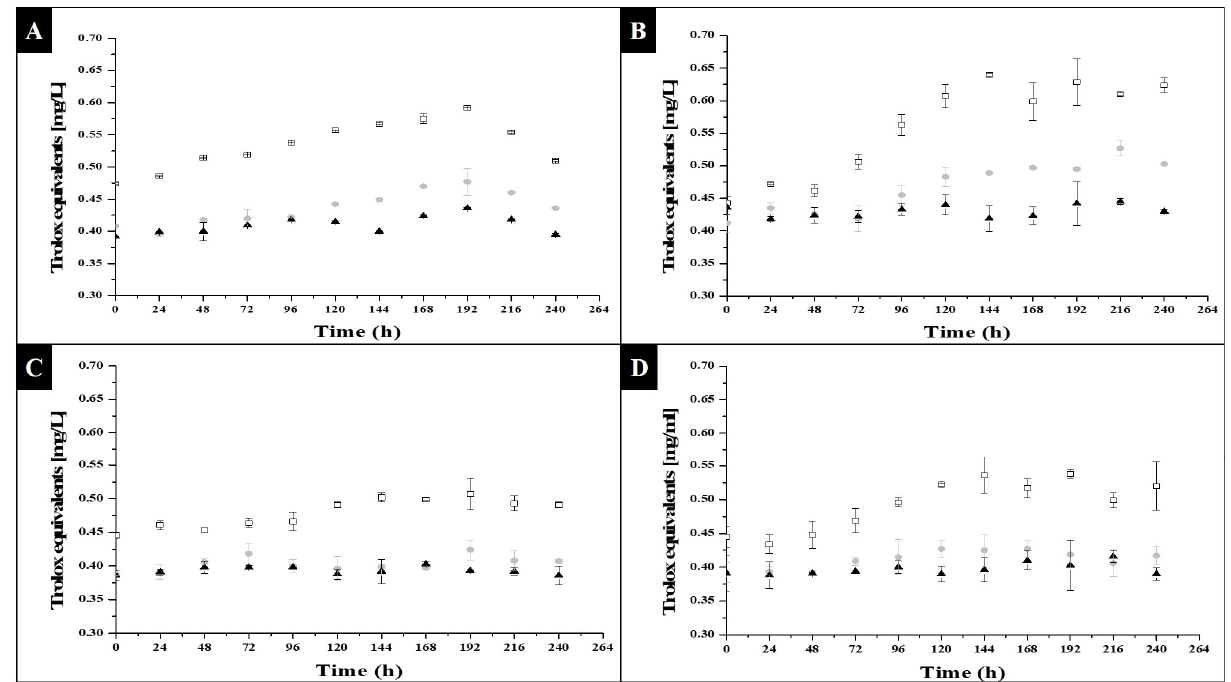
Figure 4. Antioxidant activity of C. vulgaris under photoheterotrophic growth with ABTS • + method: ( A ) sodium acetate in 8 light hours and 16 darkness photoperiods; ( B ) sodium acetate in 16 light hours and 8 darkness photoperiods. (cid:3) 0.0005 g/L, • 0.001 g/L and (cid:78) 0.0015 g/L sodium acetate concentration; ( C ) glycerol in 8 light hours and 16 darkness photoperiods; ( D ) glycerol in 16 light hours and 8 darkness photoperiods. (cid:3) 0.27 g/L, • 0.33 g/L and (cid:78) 0.44 g/L glycerol